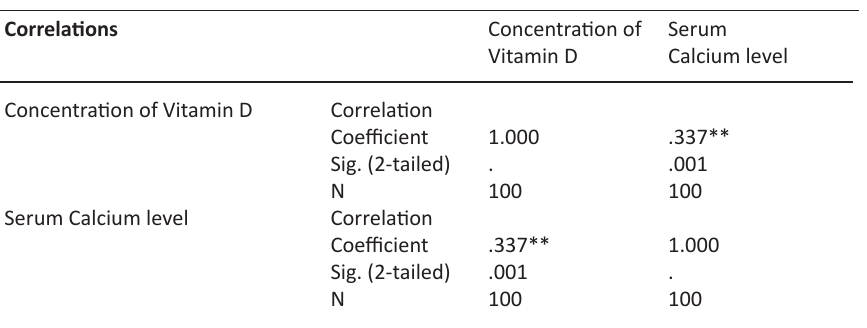
Table 2. Correlation between Concentration of vitamin D and Serum Calcium level